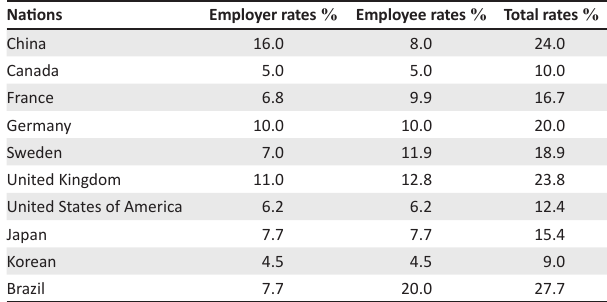
TABLE 1: Comparison of contribution rates across nations in 2016.